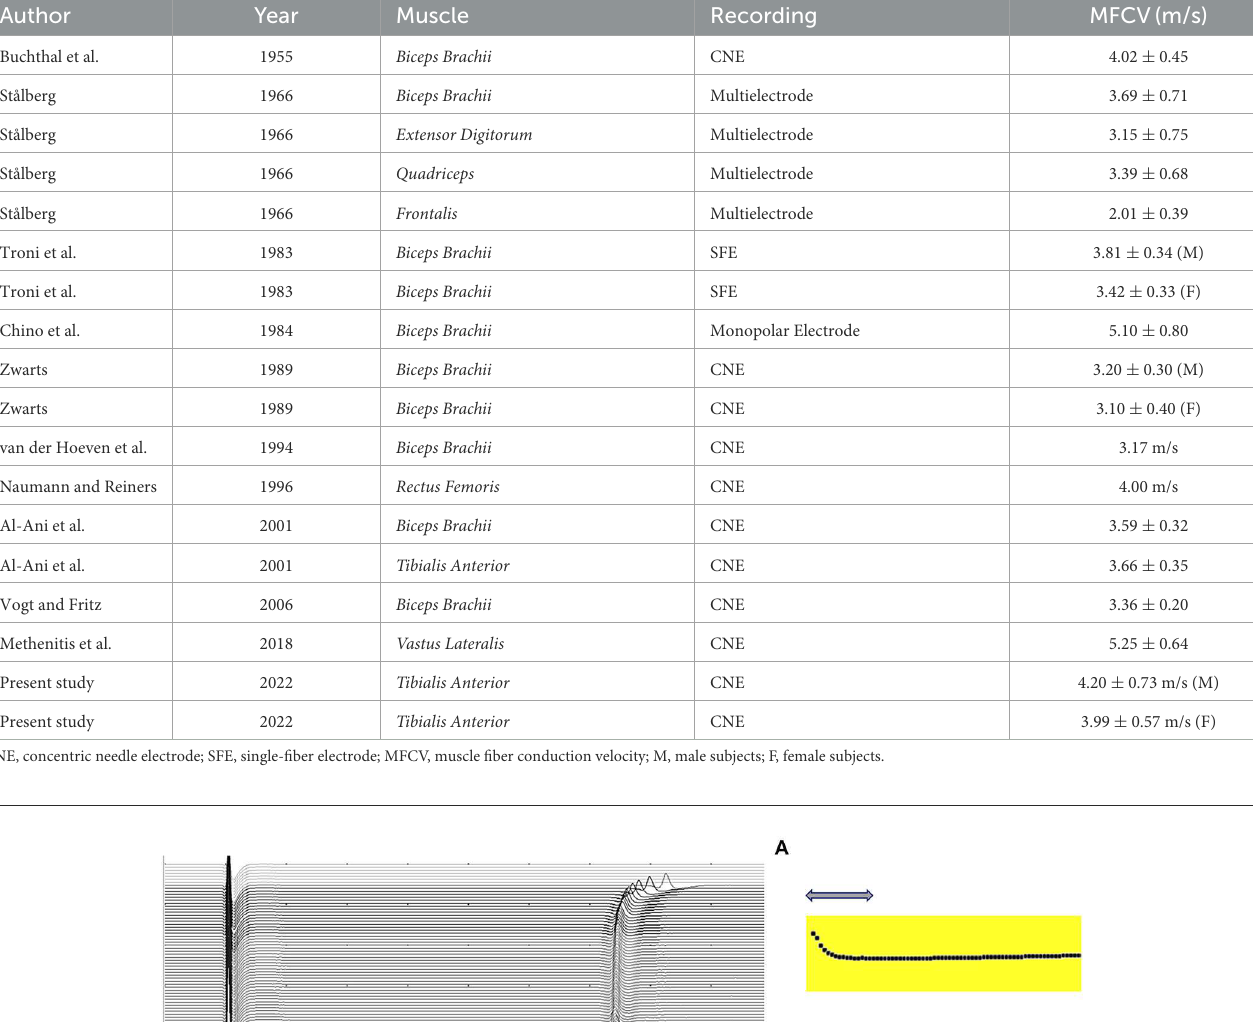
syndrome (33). The needle EMG has a limited value in steroid myopathy as the first motor unit recruited is composed of type-I fibers, which are less affected in this myopathy (33). Disuse does not alter MUAP characteristics or muscle membrane excitability